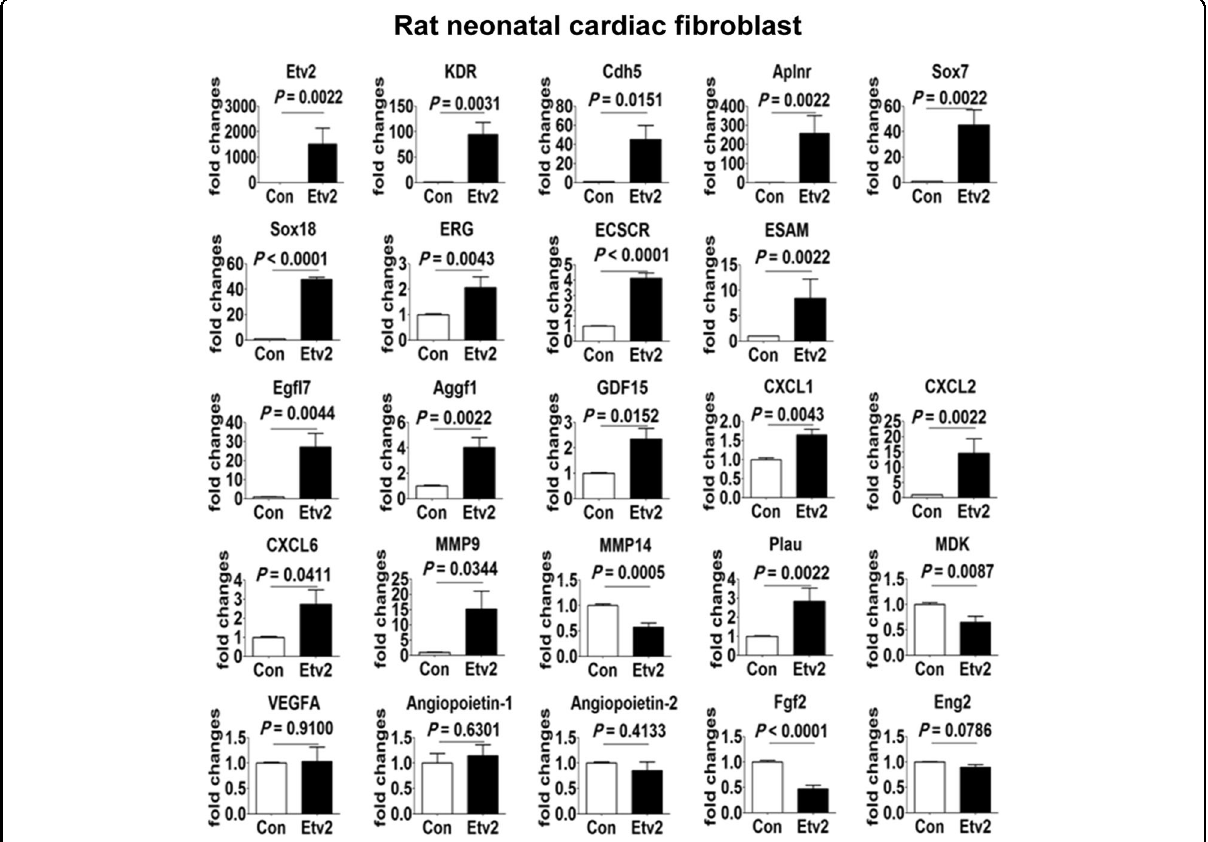
Fig. 5 Gene expression analysis in cardiac fi broblasts infected with ETV2. Rat neonatal cardiac fi broblasts infected with lentiviral ETV2 were subjected to gene expression analysis. The y -axis represents fold change in mRNA expression compared to that in control virus-infected cells. p -values were calculated compared to the control group, n =